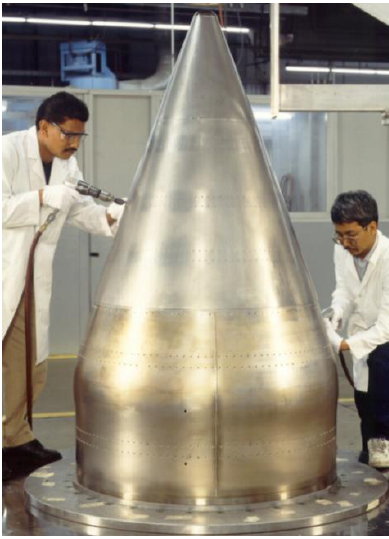
Figure 11. Fabricating the β -21s tail plug for the B-777 engine.